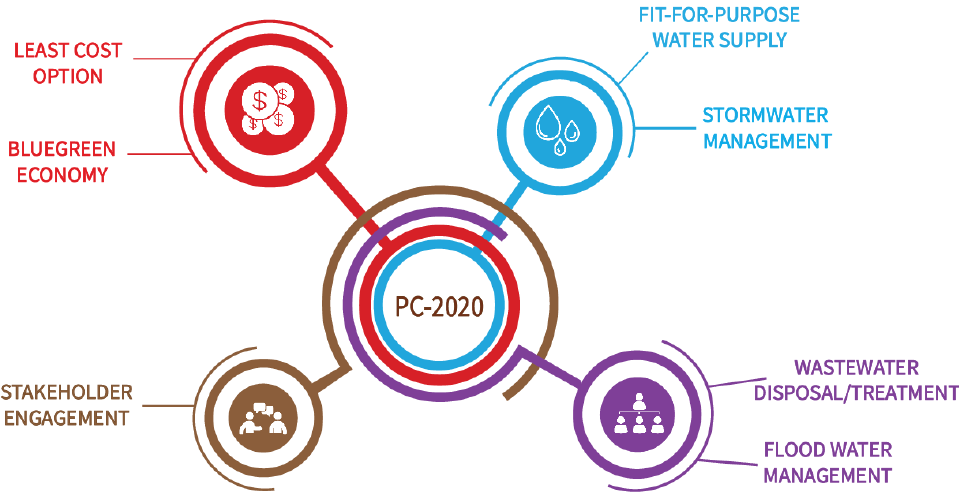
Figure 10. IWCM by PC, Australia.